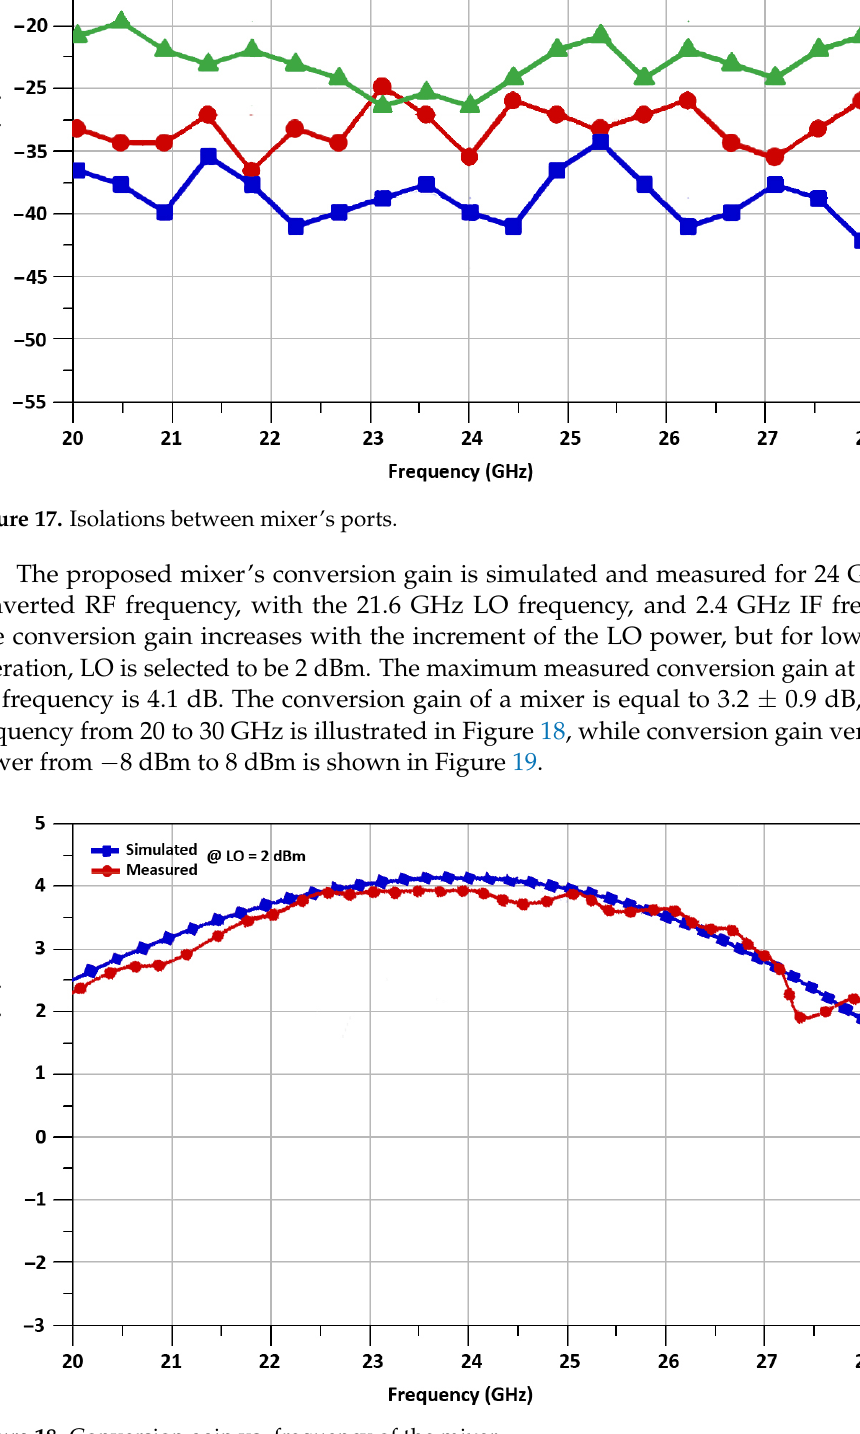
Figure 18. Conversion gain vs. frequency of the